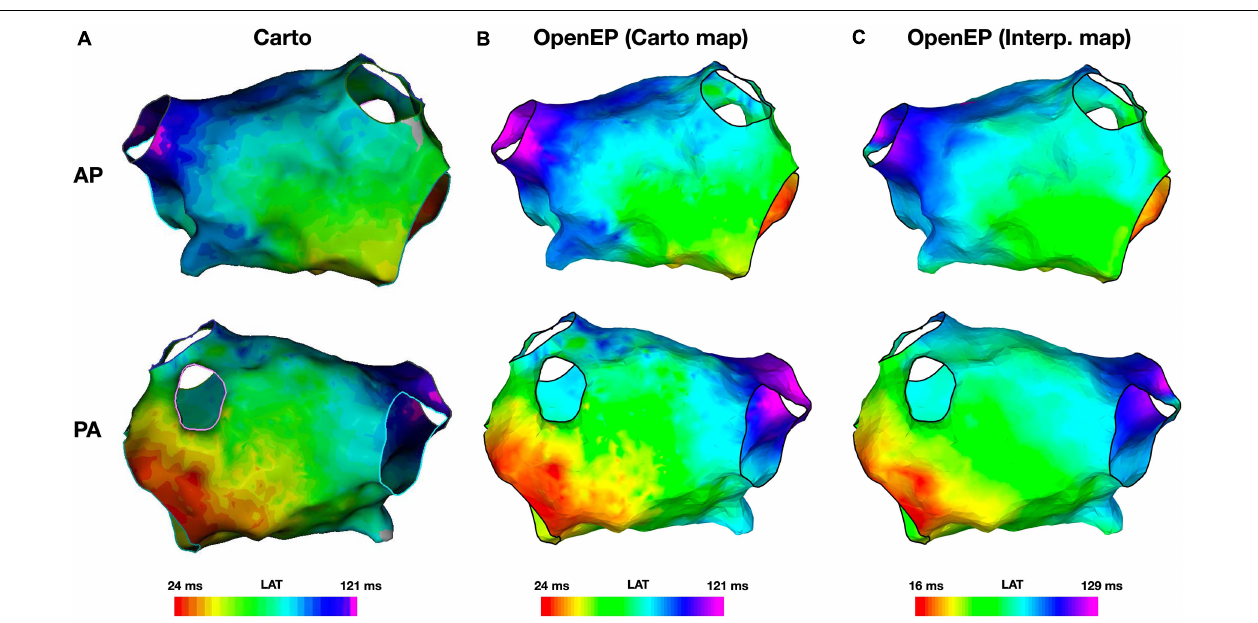
FIGURE 5 | Local activation time mapping. (A) Activation maps exported from the Carto electroanatomic mapping platform. (B) Activation map created by OpenEP using the Carto electroanatomic mapping data. OpenEP command: drawMap(userdata, 'type', 'act', 'orientation', 'ap') . (C) Activation map created by OpenEP using the Carto electrogram data. OpenEP command: interpData = generateInterpData(userdata, 'lat-map'); drawMap(userdata, 'type', 'act', 'orientation', 'ap', 'data', interpData) . AP, antero-posterior; PA, postero-anterior; LAT, local activation